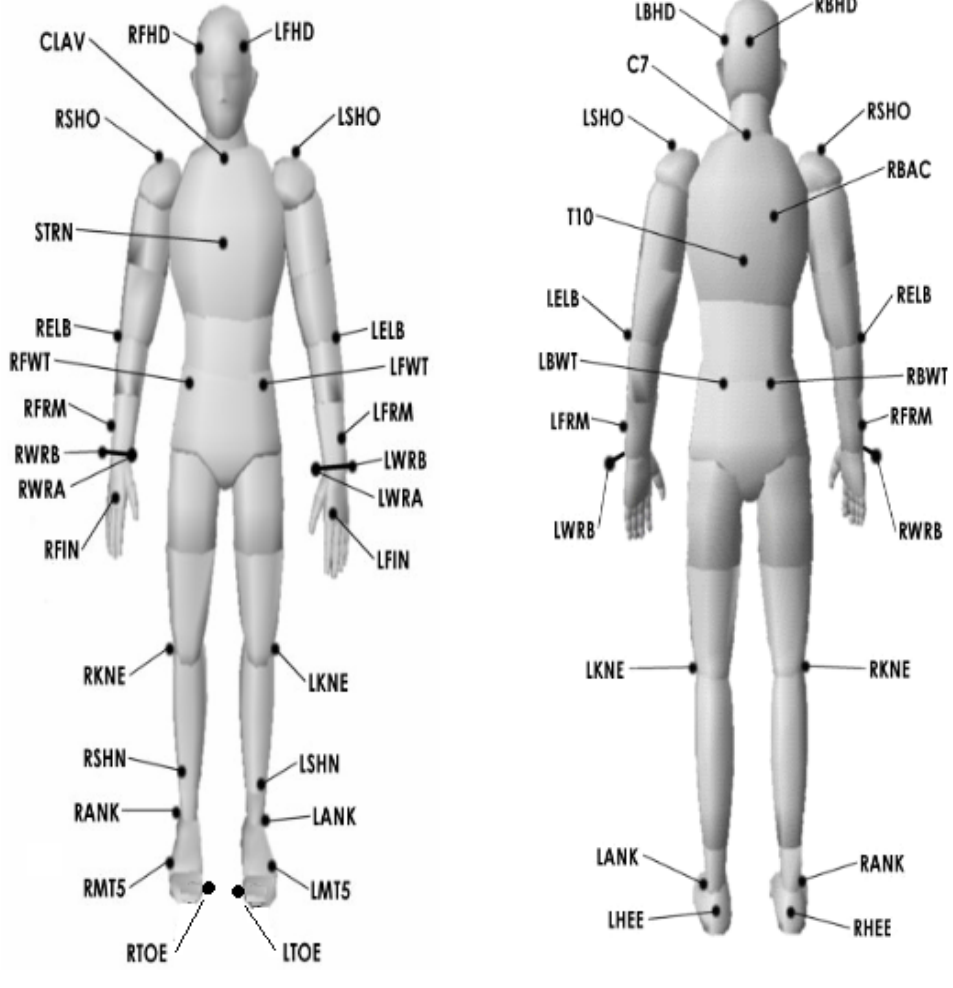
Figure 1. The locations of reflective markers .